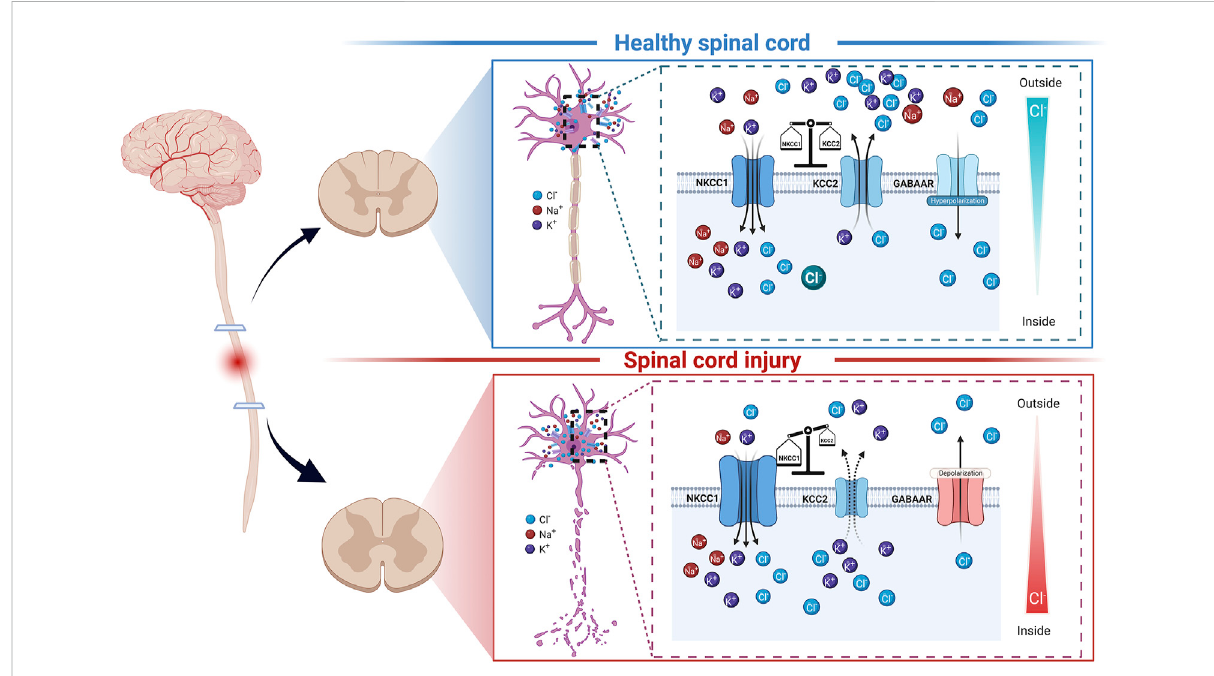
FIGURE 1 Schematic diagram of NKCC1, KCC2, GABA A Rs, and chloride ion homeostasis in spinal cord neurons under normal conditions and after spinal cord injury. In the mature, healthy spinal cord, the expression of NKCC1 and KCC2 is relatively balanced (top panel). Under this condition, the intracellular chloride ion level is low. GABA A Rs can play an inhibitory role by transporting chloride ions into cells. When spinal cord injury occurs (bottom panel), the expression of NKCC1 and KCC2 in the segment below the injury is dysregulated under the action of various factors,